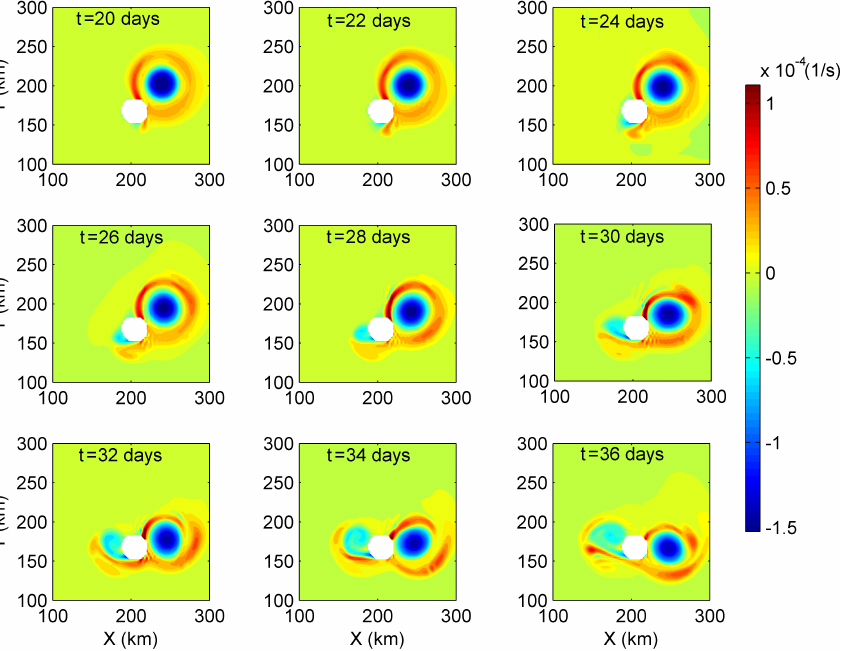
Figure 8. The temporal evolution of the eddy in the interaction with an island of 20km in diameter. The colours represent the potential vorticity anomaly (PVA) at 100m